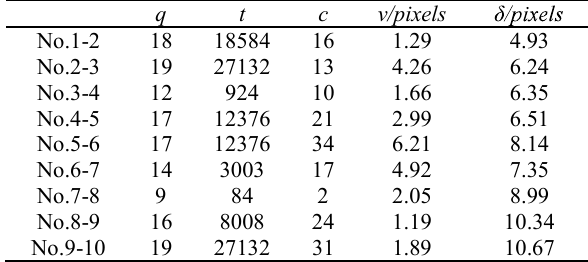
Table 3. The registration of continuous pairs in dataset I